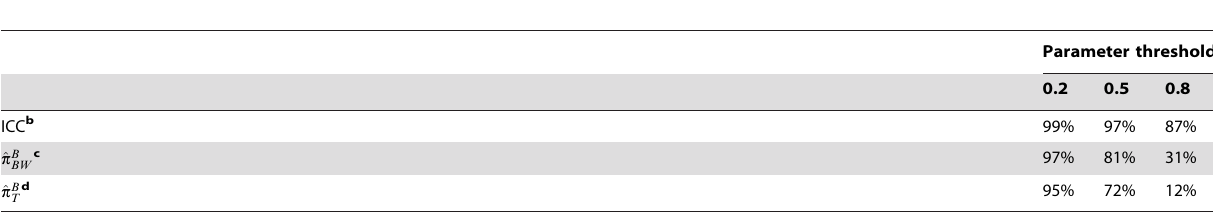
Table 1. Percentage of metabolites exceeding parameter thresholds a in the Navy Colon Adenoma